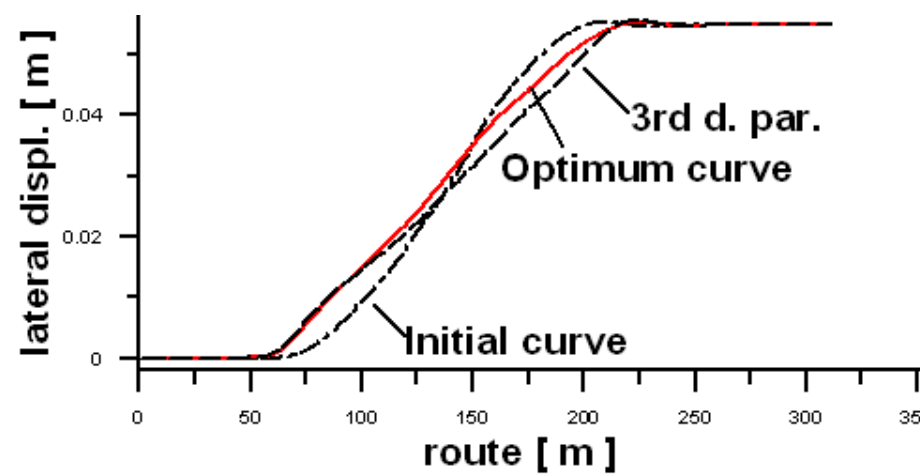
Figure 9. Lateral displacements for 9th degree (soft suspension, v = 24.26 m/s 2 ).